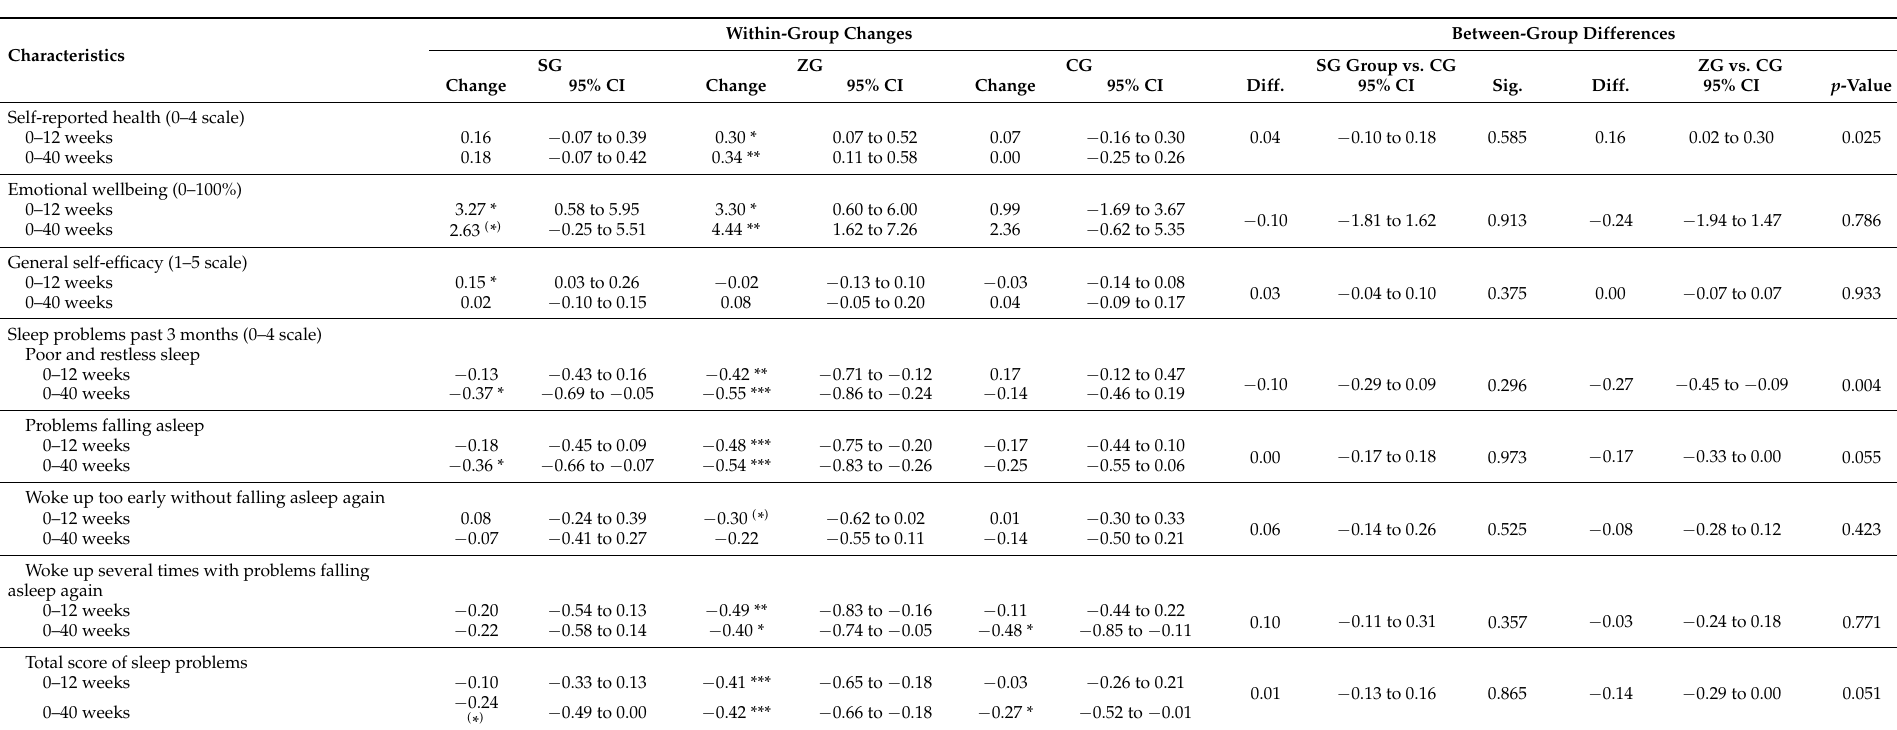
Table 2. Within-group changes and between-group differences in the soccer group (SG = 35), the Zumba group (ZG = 34) and the control group (CG = 34) during 12 and 40 weeks of